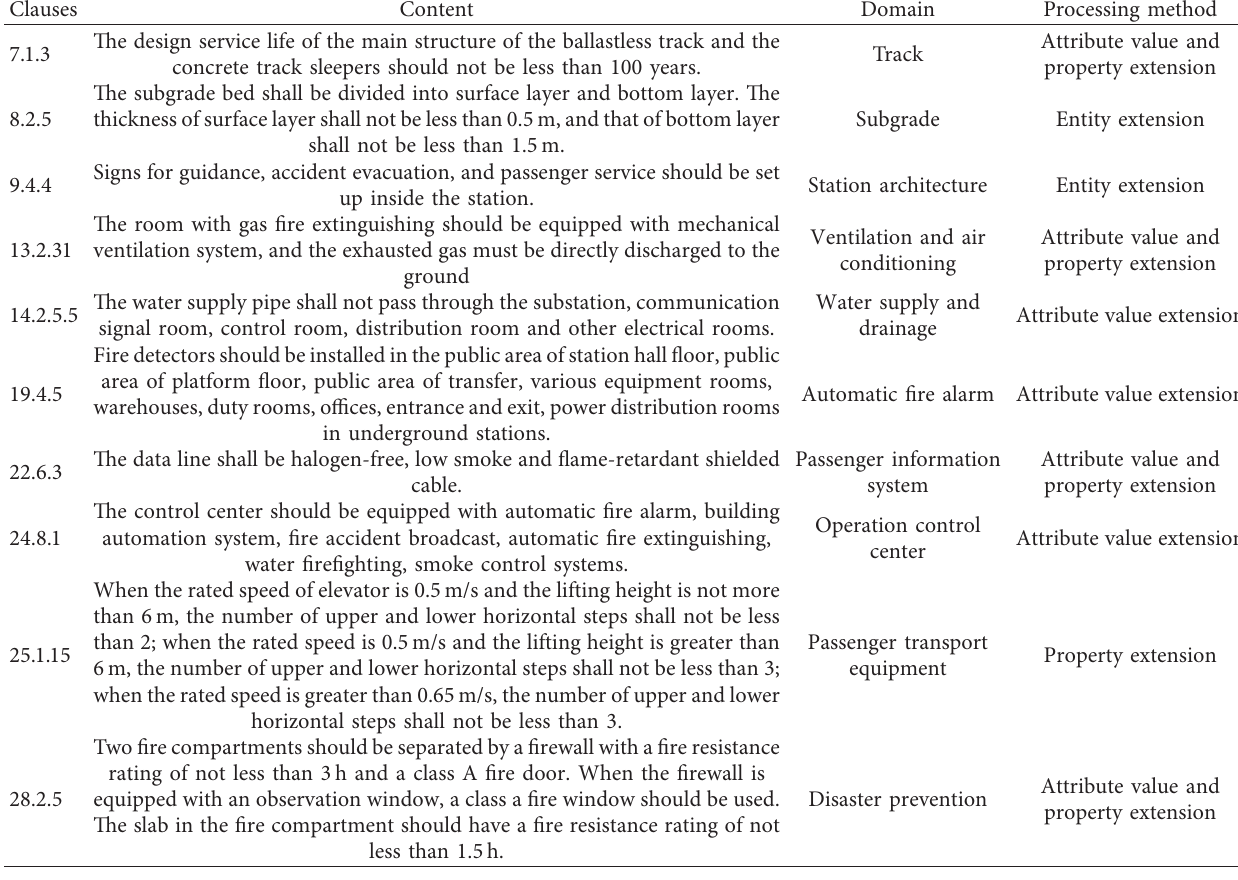
Table 2: Code clauses in experiment.